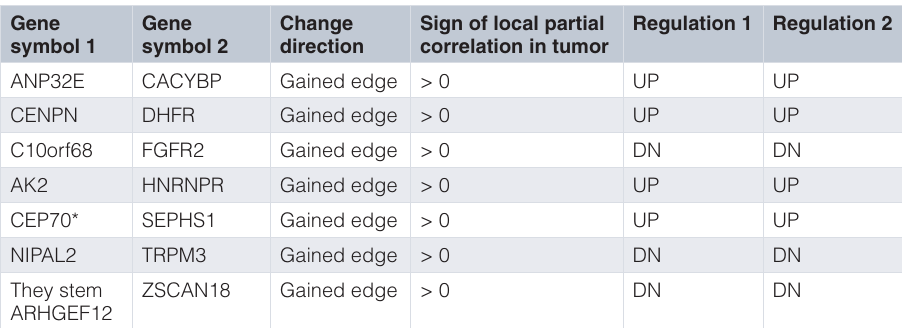
Table 1. DCPs – cancer (* key